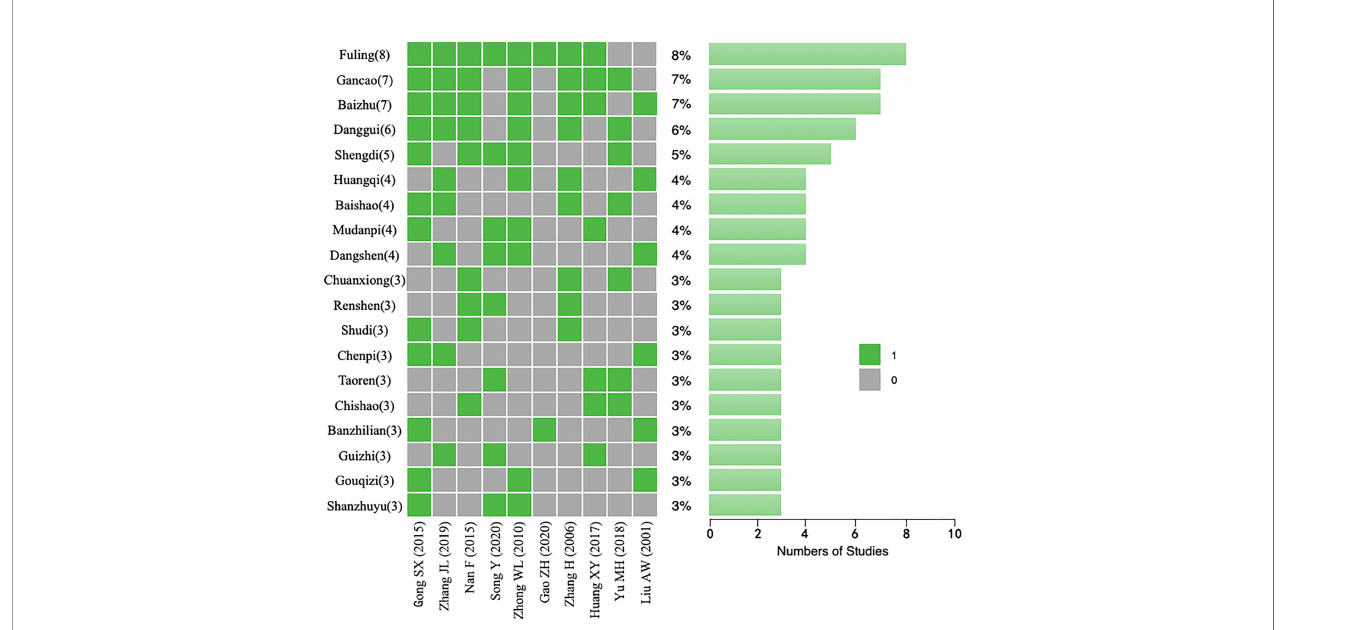
FIGURE 10 | Traditional Chinese medicine (TCM) herbs that appeared in each